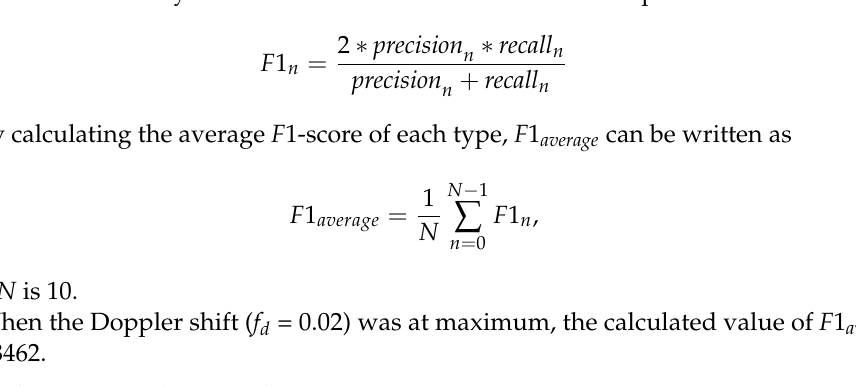
Figure 6. The classification results of samples with f d = 0.02.